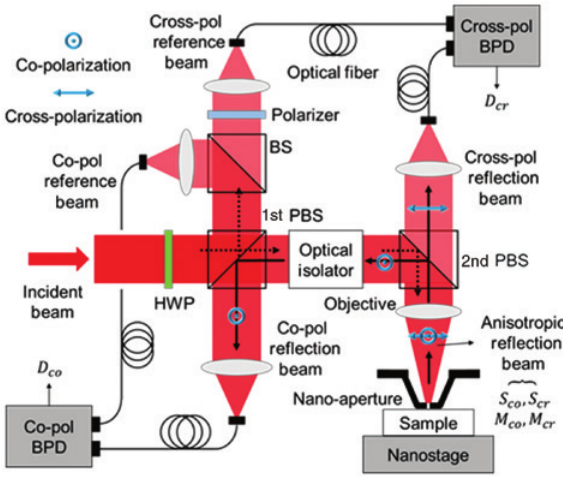
Figure 3: Schematic of a plasmonic near-field scanning nanoscope (PNSN) which collects both polarization components of the anisotropic reflection from the nano-aperture by applying a cross- polarization detection technique.